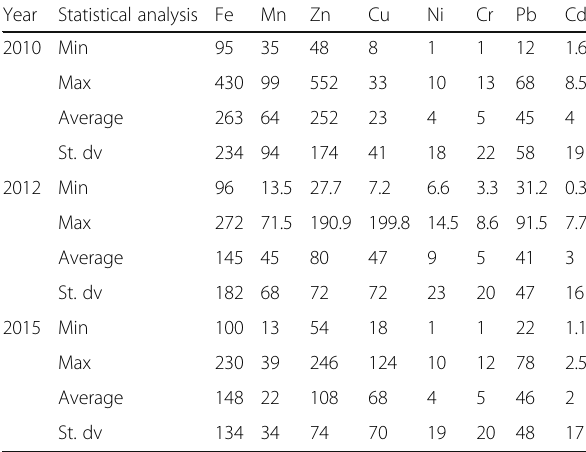
Table 8 Statistical analysis of heavy metals during 2010, 2012, and